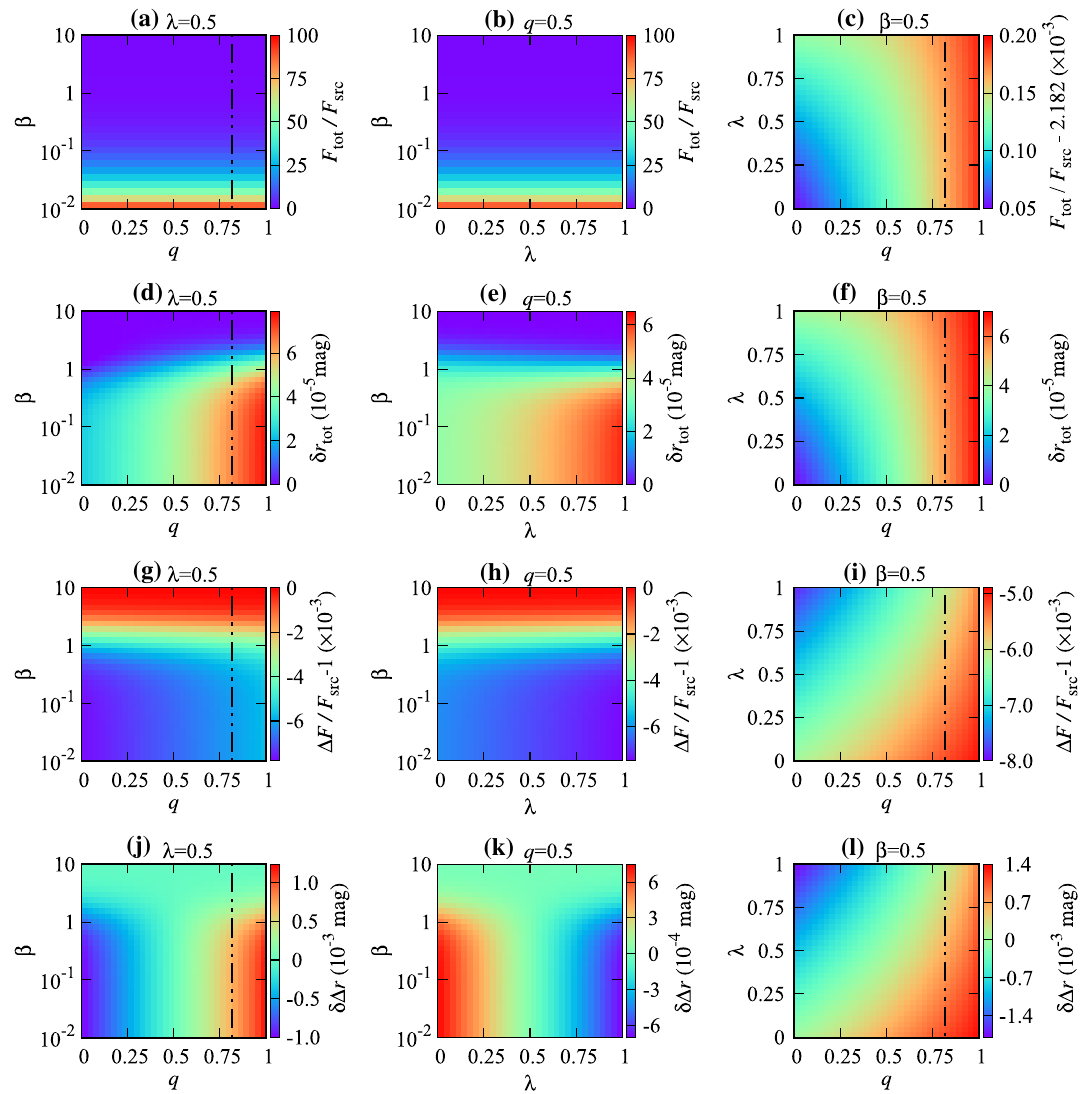
Fig. 3 From top to bottom, color-indexed F tot , δ r tot , δ r tot and δΔ r in the weak deflection gravitational lensing for Sgr A* are shown on the domains of D λ , D q and D β (from left to right). The dash-dotted lines mark the upper bound on q based on the shadow of M87* observed by EH